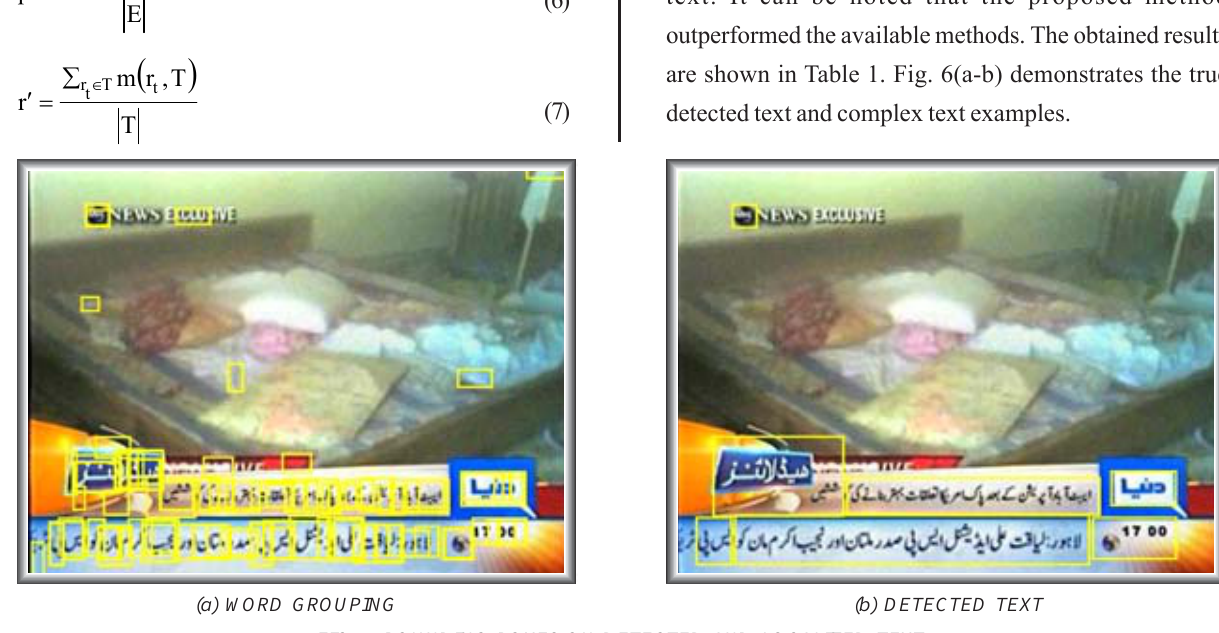
FIG. 5. BOUNDING BOXES ON DETECTED AND LOCALIZED TEXT. TABLE 1. PERFORMANCE COMPARISON OF PROPOSED